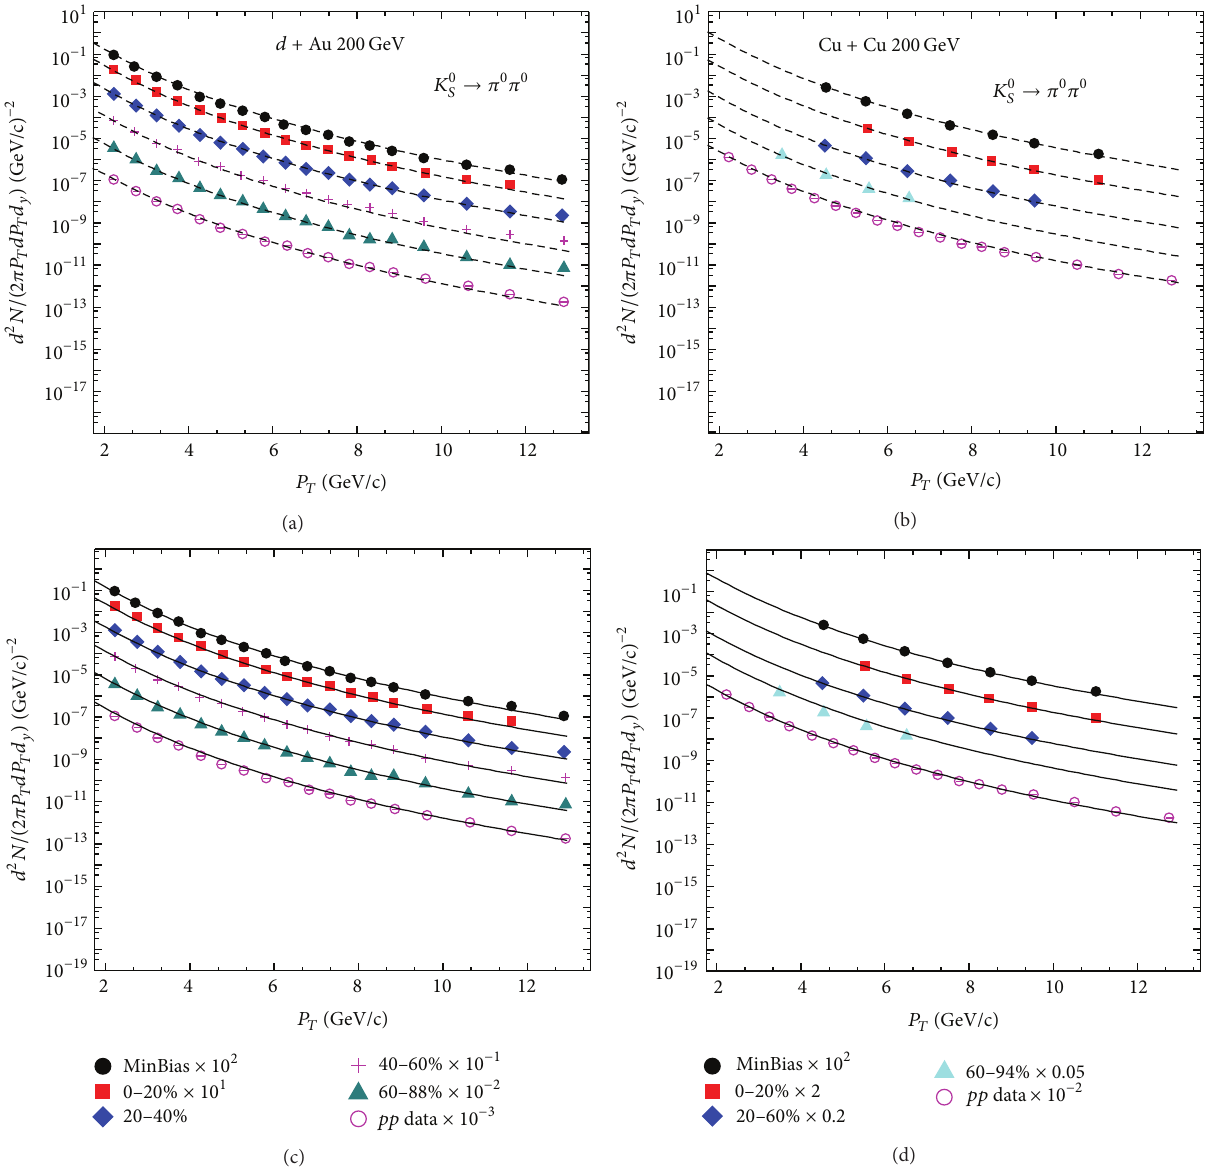
Figure 1: 𝐾 0 𝑆 transverse momentum spectra in 𝑑 + Au and Cu + Cu collisions for different centrality bins and 𝑝 + 𝑝 collisions at √𝑠 𝑁𝑁 = 200 GeV.Experimentaldata[11–15]areshownwithdifferentsymbols.Thedashedlinesandsolidlinesaretheresultsof(4)and(5),respectively.